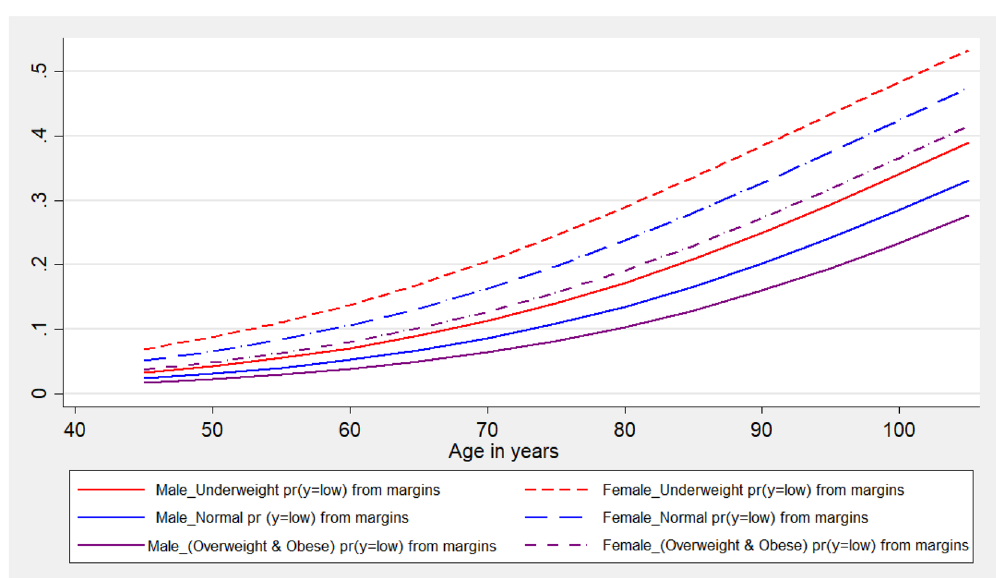
Figure 3. The gender pattern of average marginal effects of age on low cognition by body mass index (BMI) among older adults, LASI, Wave 1,